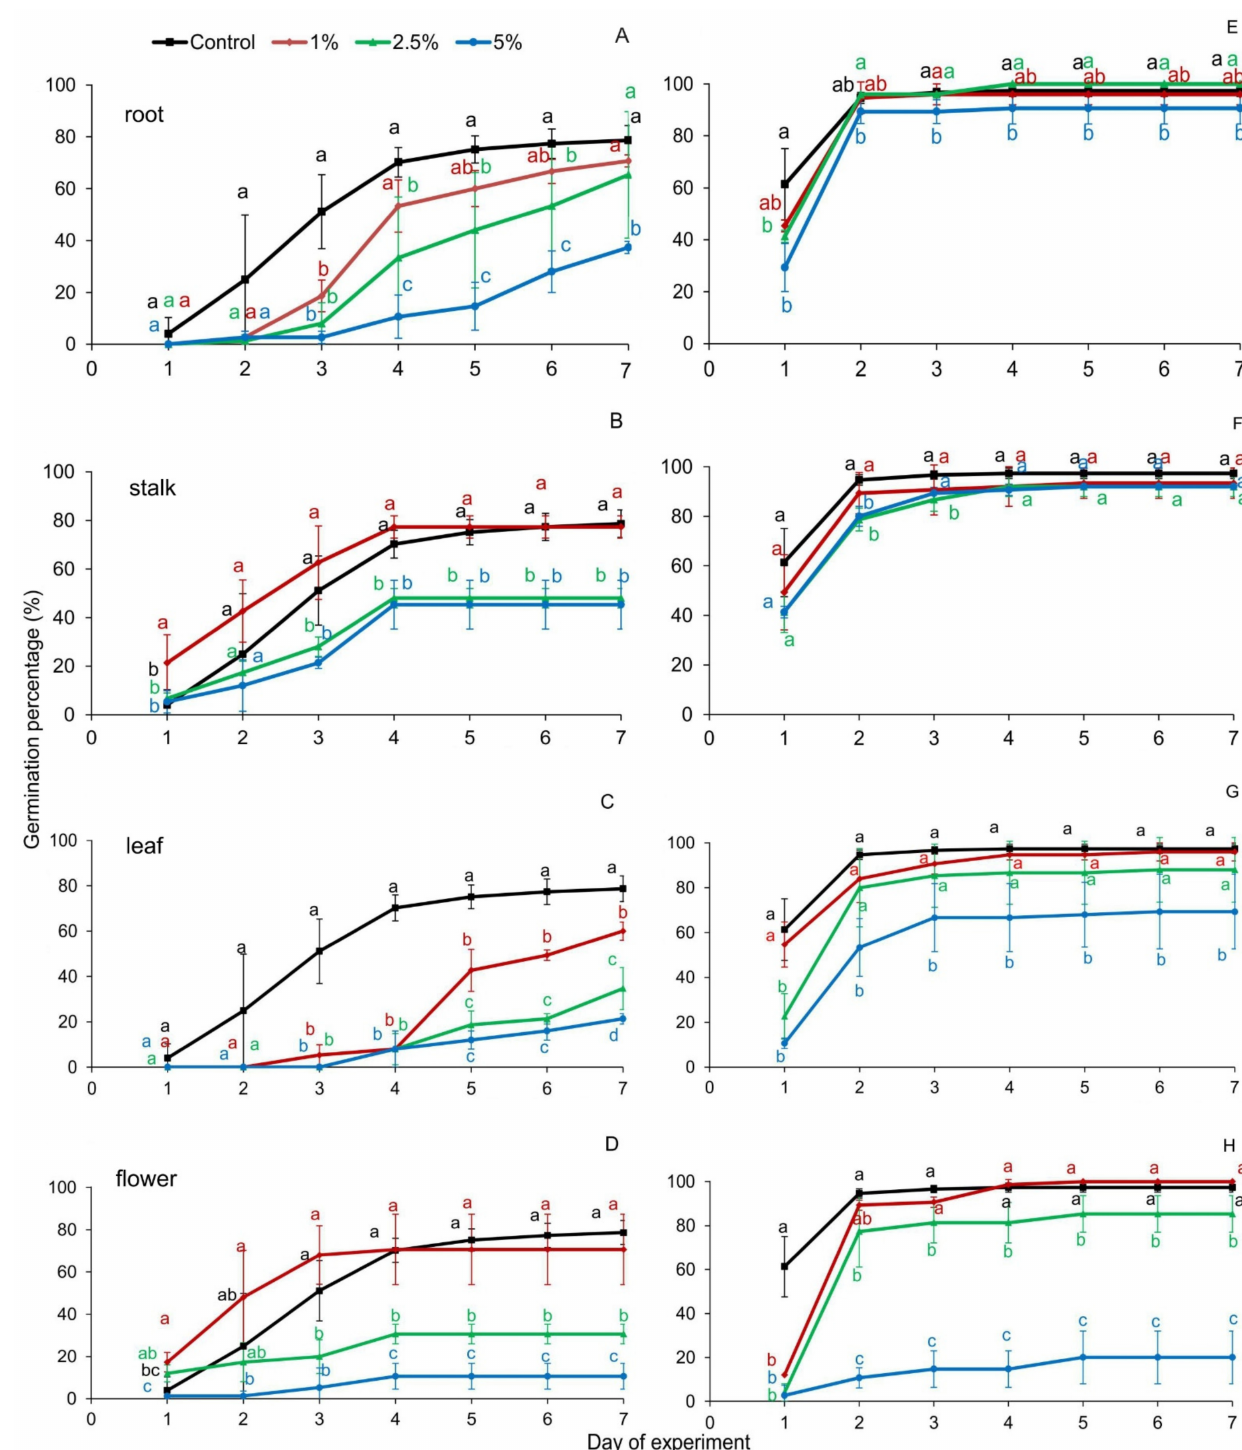
Figure 2. Germination percentage of Festuca rubra L. ( A – D ) and Raphanus sativus L. var. radicula Pers. cv. Rowa ( E – H ) seeds, treated with organ extracts of Rosa blanda Aiton with various concentrations (1%, 2.5%, 5%); aqueous extracts from the following parts of the rose: ( A , E )—root, ( B , F )—stalk, ( C , G )—leaf, ( D , H )—flower; the mean values of the three replicates ( n = 10, ± SD) marked with different letters are significantly different according to Duncan’s test p ≤